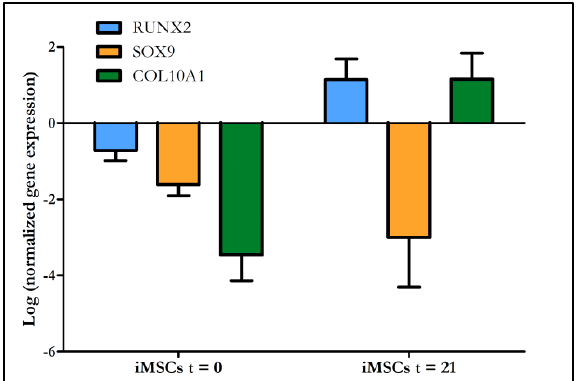
Figure 7. Relative expression levels (RELs) of Runx2, Sox9 and Col10A1 in iMSCs spheroids at the beginning of the experiment (t = 0) and after 21 days of chondrogenic induction (t = 21). RELs of each gene were scaled to the REL of the same gene in primary chondrocyte spheroids. Data obtained from iMSC#6, iMSC#9 and iMSC#10 spheroids were employed to calculate the mean values shown.